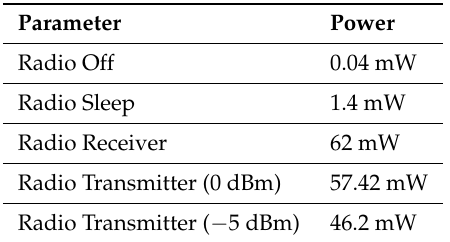
Table 2. Power consumption in CC2420